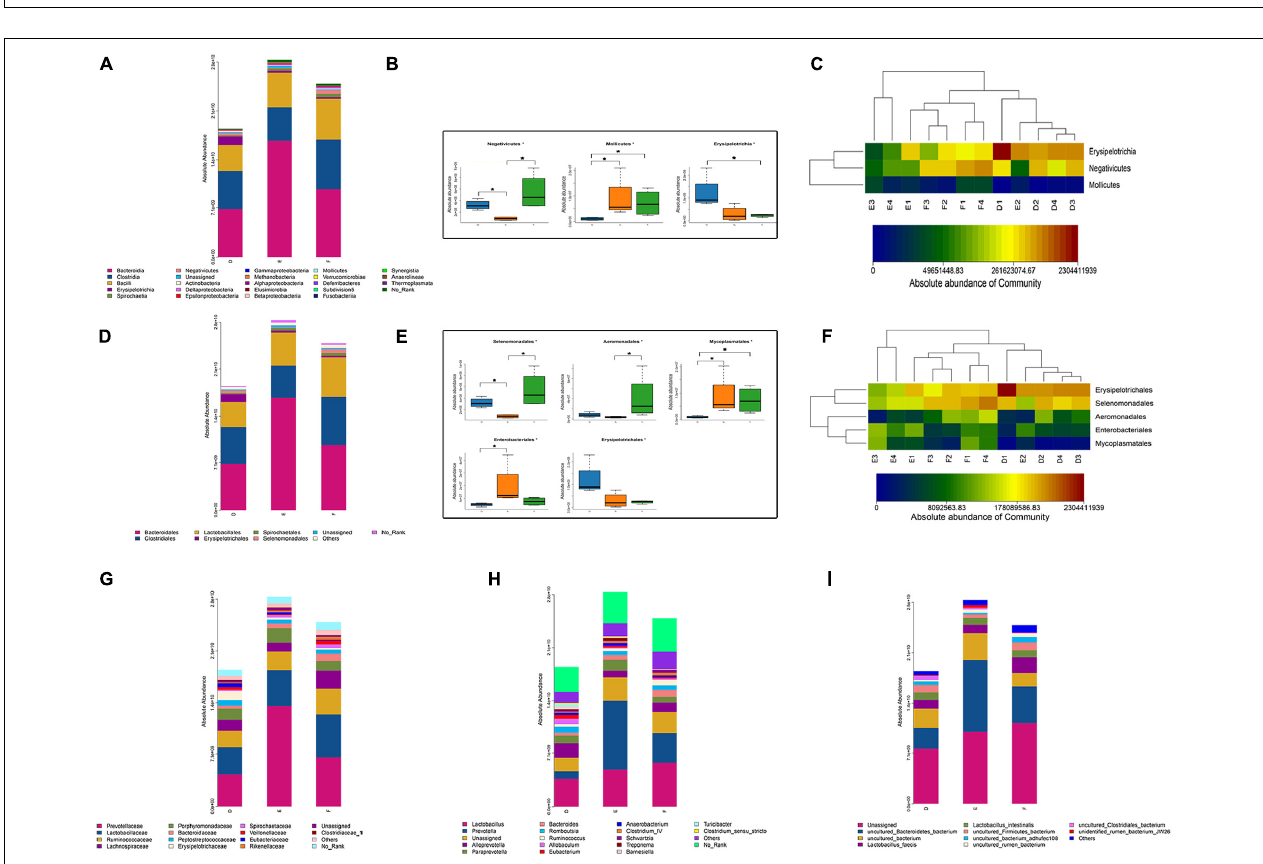
FIGURE 6 | Composition of the gut microbiota ( n = 4/group): (A) the absolute abundance of major bacterial taxa at the class level; (B,C) significant different bacteria at the class level. The data were analyzed by one-way ANOVA (* p < 0.05); (D) the absolute abundance of major bacterial taxa at the order level; (B,C) significant different bacteria at the order level. The data were analyzed by Kruskal–Wallis (* p < 0.05); (G–I) the absolute abundance of major bacterial taxa at the family, genus, and species